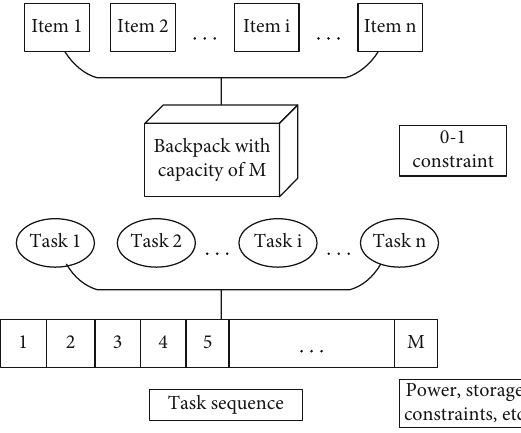
Figure 8: Comparison between satellite mission planning problem and backpack problem model.